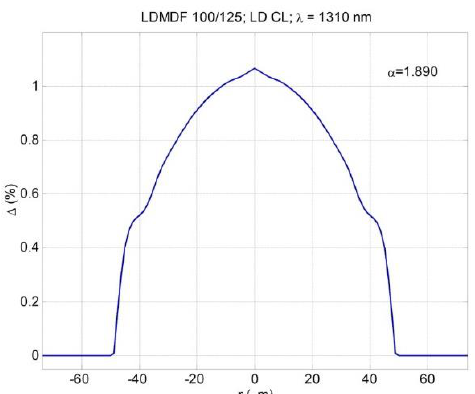
Figure 1. Selected sample of optimized graded refractive index profile for 100- µ m core laser-optimized multimode optical fibers (LOMF).